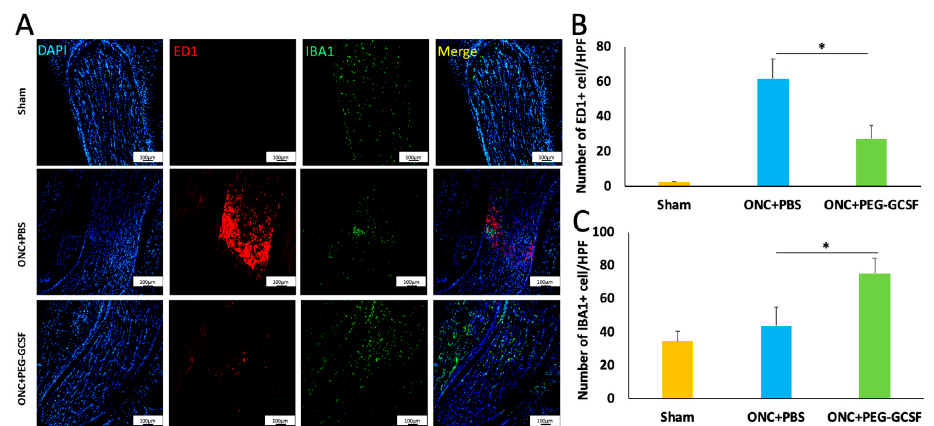
Figure 7. Immunohistochemistry of ED1 and Iba1 in sections of optic nerves (ONs) two weeks post- operation of the sham or the optic nerve crush (ONC). ( A ) Representative images of ED1 and Iba1 staining in longitudinal sections of the ONs. The ED1-positive cells were marked in red color, while the Iba1 were marked in green color. The cell nuclei were labeled in blue color. ( B ) Quantification of ED1-positive cells per high-power field (HPF). The number of ED1-positive cells was significantly lower in the pegylated granulocyte colony-stimulating factor (PEG-G-CSF)-treated group when compared with the phosphate-buffered saline (PBS)-treated group (* p < 0.05). ( C ) Quantification of Iba1-positive cells per HPF. The number of Iba1-positive cells was significantly higher in the PEG- G-CSF-treated group when compared with the PBS-treated group (*: p < 0.05). Data are expressed as mean ± standard deviation (SD) (n = 6 per group; scale bar = 100 µm).